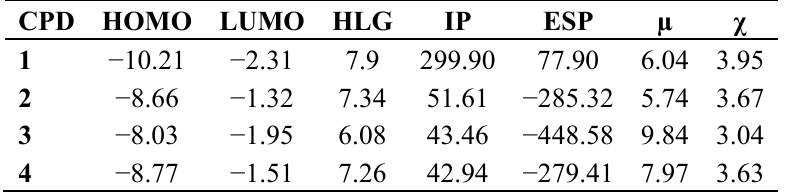
Table 4. The optimized calculatedenergies atthe semi-empirical PM3 level for 1 – 4